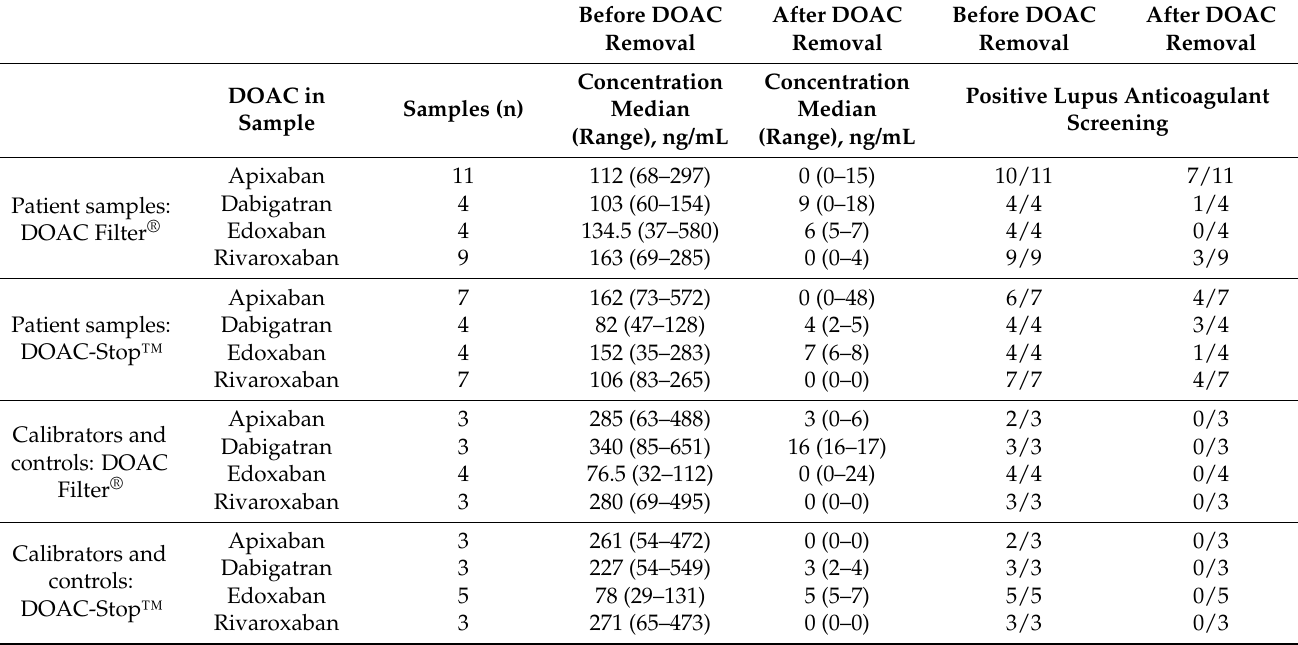
Table 1. DOAC concentrations and Lupus anticoagulant results before and after DOAC